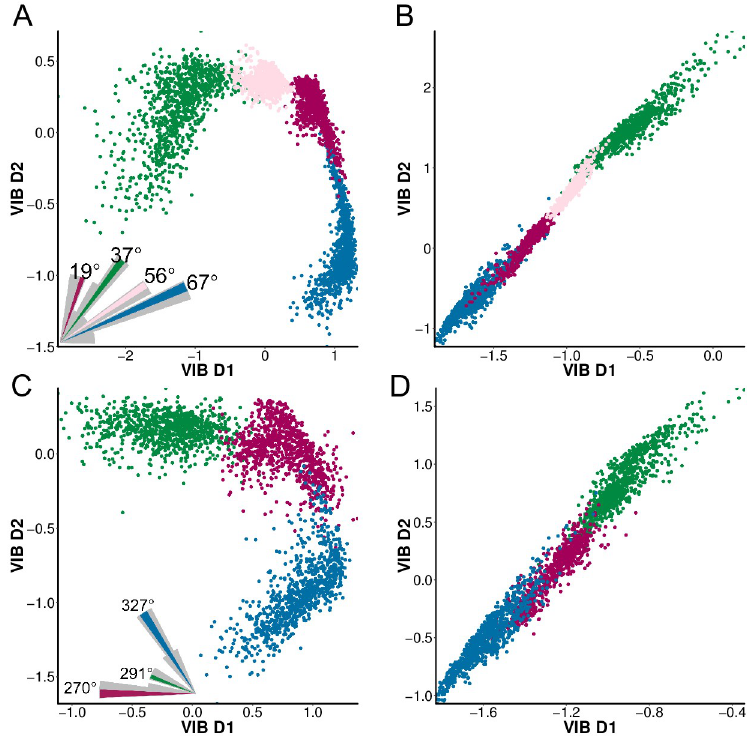
Fig 5. The predictive information encoded by the VS network supports fine scale discrimination of future ego- rotation. (A) The predictive representation of four future ego-rotations in the same quadrant of roll and pitch, e.g. an up-tilt and a clockwise roll. This representation maps the axonal voltage of the entire VS network to future ego- rotation through a latent feature space. The dimensions in this latent feature space (shown as VIB D1 and VIB D2) are VIB-learned predictive features based on the output of the VS network. All ego-rotation correspond to vectors within the 1st quadrant of the fly’s coronal plane. The inset shows a polar histogram in grey and the four selected ego- rotations in color. (B) Similar to A but using the axonal voltages of the VS 5-6-7 triplet. (C) Similar to A, but ego- rotation are all counter-clockwise roll and up-tilt, corresponding to vectors in the 4th quadrant (between 270˚ and 360˚) of the fly’s coronal plane. (D) Similar to C, but obtained using the axonal voltages of the VS 5-6-7 triplet as the VIB input. Note that although the overall correlation is high for the VIB solution using the axonal voltages of the VS 5- 6-7 triplet, the VIB D1 and VIB D2 encode different information about θ : VIB D1 encodes 1 bits about θ and future future VIB D2 encodes an additional 0.3 bits. Ego-rotation representations are different if the system is optimized for prediction as opposed to optimized for encoding the present input. For example, the VIB-based predictive representation not only separates nearby ego-rotations (e.g. 56˚ and 67˚) into distinct clusters, but also inserts a cluster of another ego-rotation angle (e.g, 19˚) between them. By contrast, the disentanglement implemented by a circuit that maximally encodes the instantaneous inputs projects all distinguishable ego-rotations into adjacent clusters according to their azi- muthal angle, i.e. 56˚ and 67˚ are next to each other. Because predictive representations contain less absolute information about the ego-rotation than the instantaneous-optimal representation, this difference suggests that the predictive information might preferentially support fine-scale discrimination of nearby ego-rotations. Information is not necessarily lost, however. Downstream, at the descending motor neurons [82–85] or the neck motor center [86, 87], information from other pathways (e.g. the haltere and prosternal organs [40]) is inte- grated. Thus, the discrimination of larger ego-rotation angles may be supported, while allow- ing the VS system to serve a specialized role in fine discrimination.